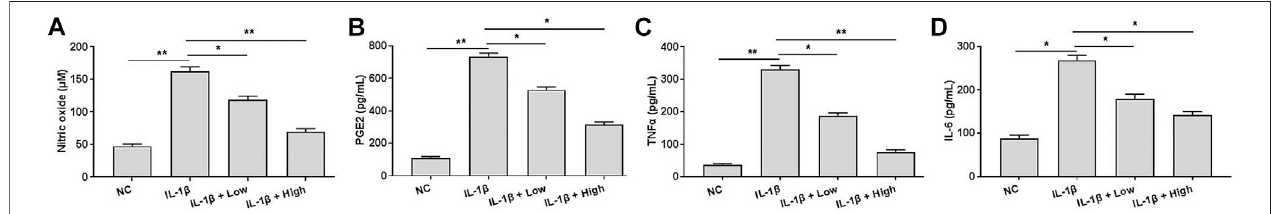
FIGURE 3 | Effects of XH on the production of NO, PGE 2 , TNF α , and IL-6 in IL-1 β -treated chondrocytes. (A) The production of NO was determined. (B) The production of PGE